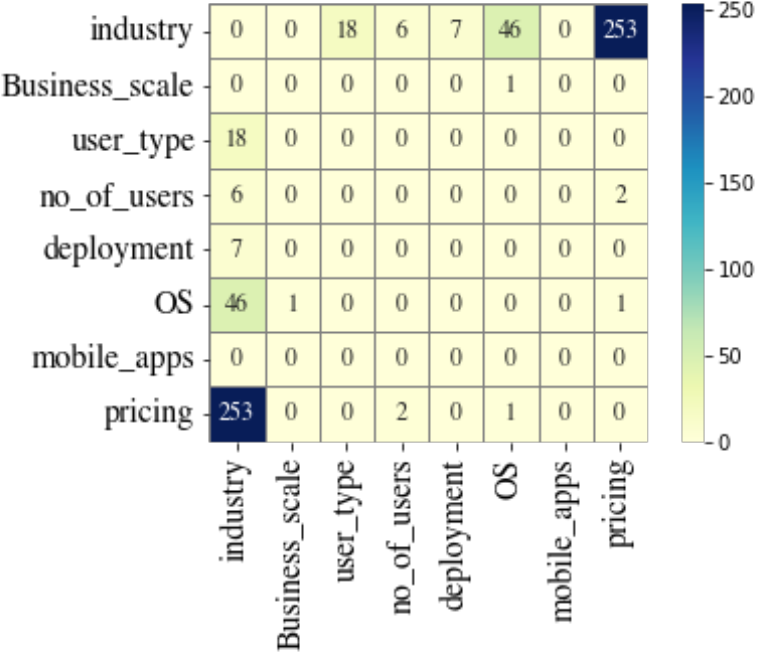
Figure 1. Associations detected in the BI Software recommendation data set. Table 5. An example of the 253 relationships found between the industry and price variables. The contingency table is